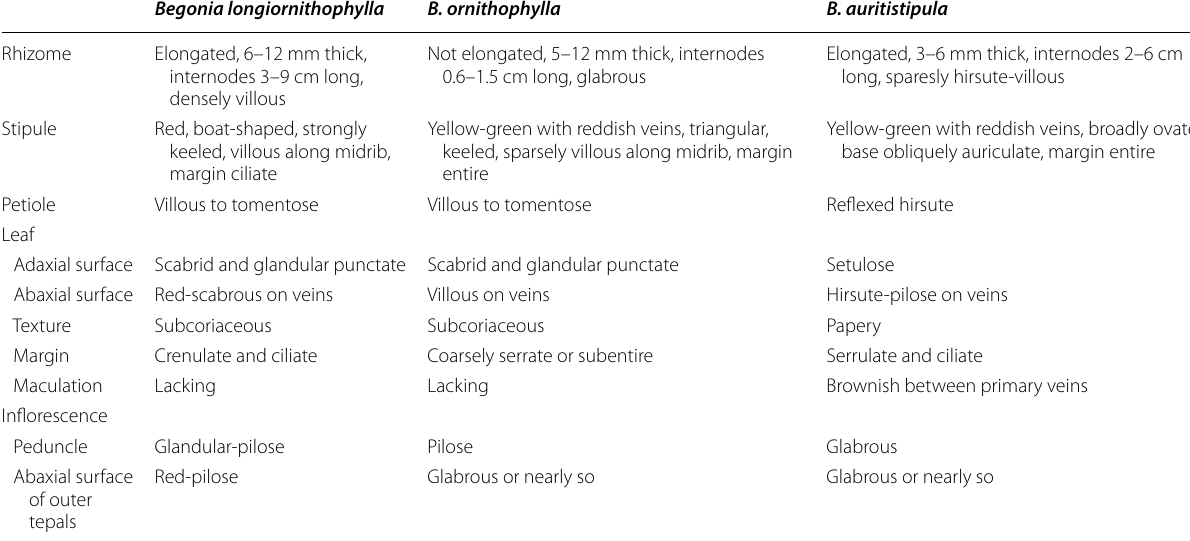
Table 2 Comparison of Begonia longiornithophylla with B. ornithophylla and B. auritistipula Begonia